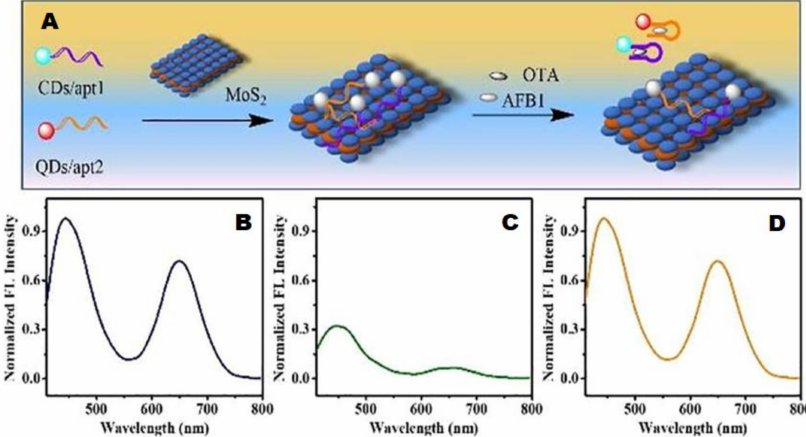
Figure 11. ( A ) Schematic representation of fabrication and sensing of aptasensor, fluorescence spectra of blend CDs/apt1 and QDs/apt2; ( B ) before bioconjugation; ( C ) after bioconjugation; ( D ) incubation with 20 mg/mL of toxins aflatoxin-B1 and ochratoxin A, reproduced with permission from [72] (Jing Qian et al.,